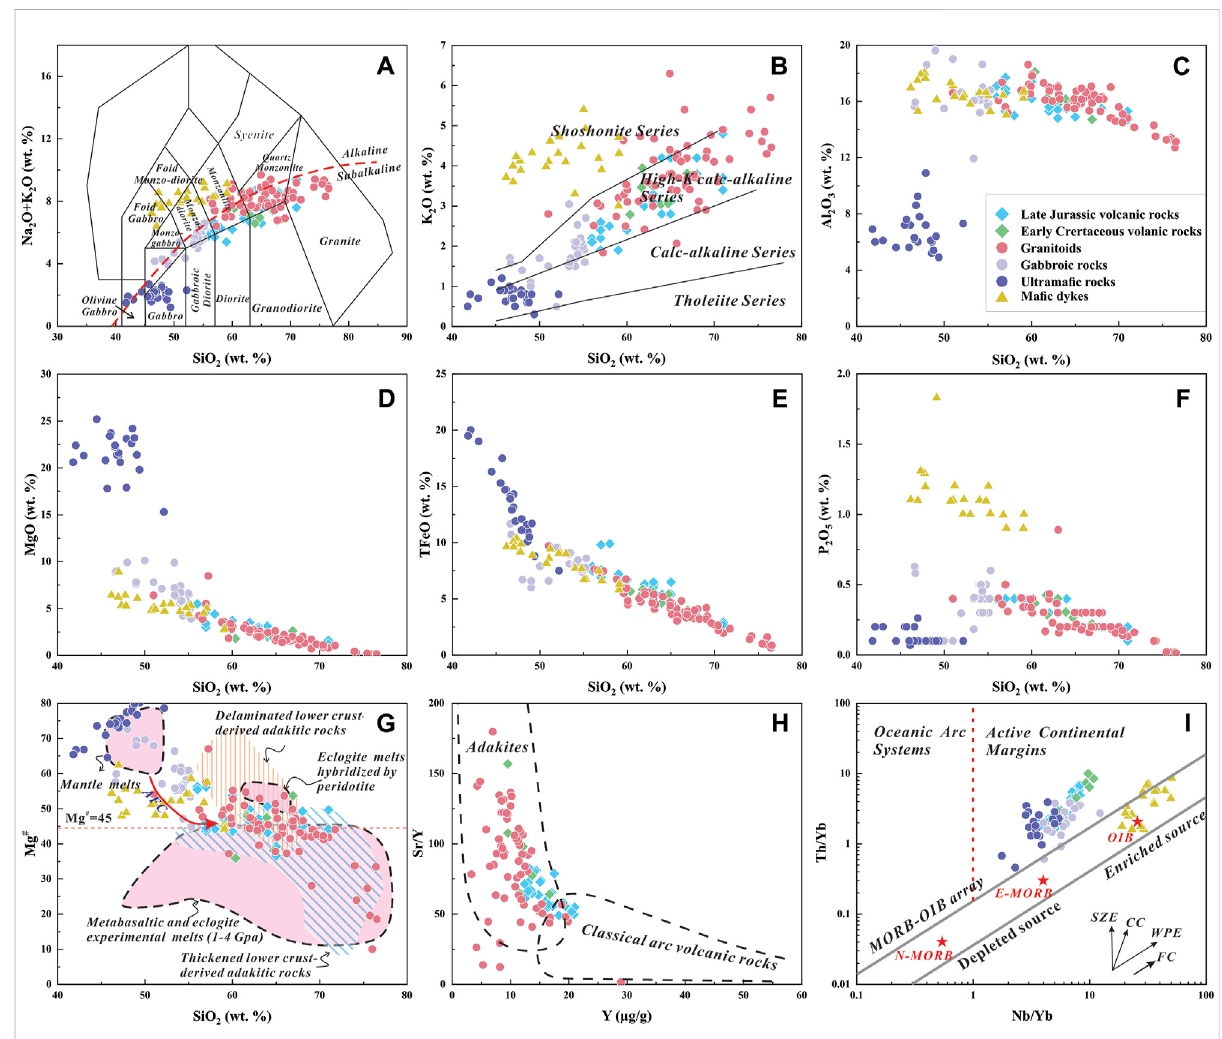
FIGURE 4 (A) TAS diagram for Laiyuan magmatic rocks (Middlemost, 1994). (B) K 2 O vs SiO 2 classi fi cation diagram (Peccerillo and Taylor, 1975). (C – F) Selected major elemental variation diagrams for the Laiyuan magmatic rocks. (G) Mg # vs SiO 2 (wt%) diagram. AFC curve is modi fi ed after (Stern and Kilian, 1996). Fields of metabasaltic and eclogite experimental melts hybridized with peridotite are after (Rapp et al., 1999). Field of metabasaltic and eclogitic melts (1 – 4 GPa) is after (Wang et al., 2006) and (Rapp and Watson, 1995). Fields of delaminated and thick lower crust-derived adakitic rocks are after (Wang et al., 2006). (H) Sr/Y vs Y diagram. Fields of adakites and classical island andesite – dacite – rhyolite rocks are modi fi ed from Defant and Drummond (1990). (I) Th/Yb vs Nb/Yb diagram (after Pearce, 2008). Data source: Chang et al., 2021; Chen et al., 2003; Chen and Zhai, 2003; Gao et al., 2012; Gao et al., 2013; Hou et al., 2015; Liu et al., 2010; Qu, 2012; Xue et al., 2019b; Xue et al., 2020; Xue et al.,